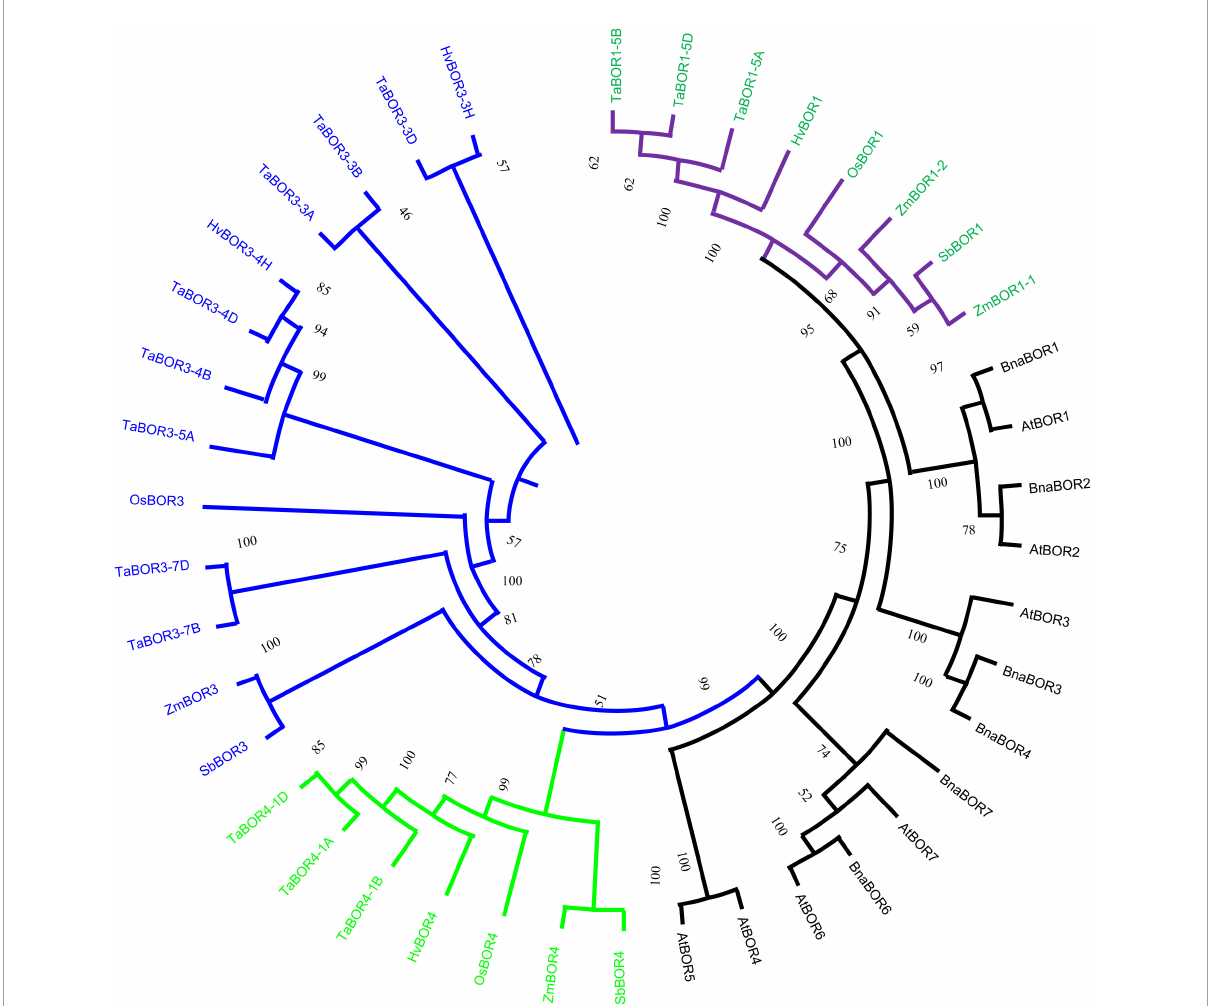
FIGURE1 Phylogenetic analysis for BOR s in monocot and dicot plants. Subfamilies are marked by branch colors. Green and black font represents the BOR genes in monocot and dicot